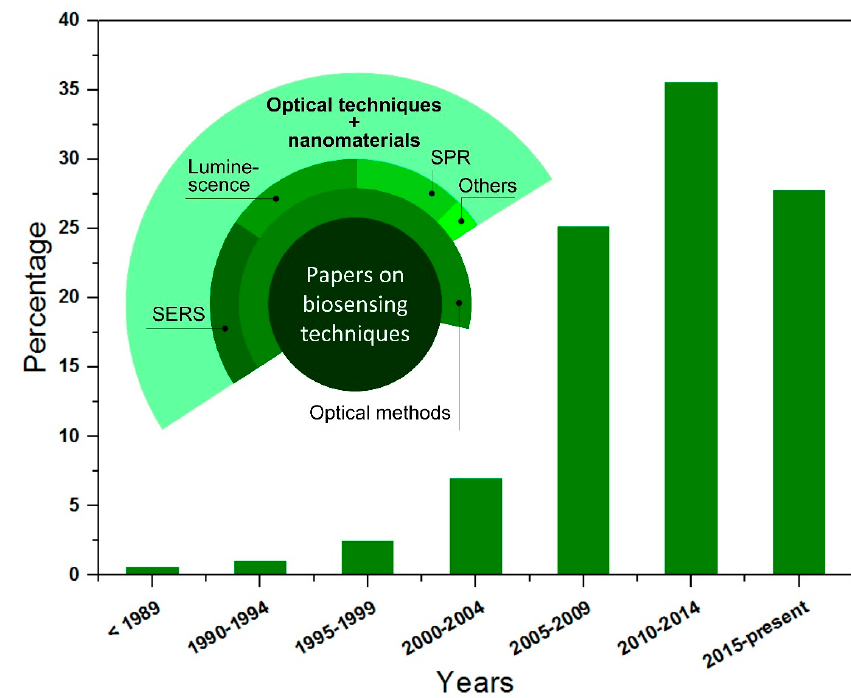
Figure 1. Number of papers on biosensing by year; inset shows the distribution of papers on biosensing based on the technique used (Google Academy, accessed on 30 November